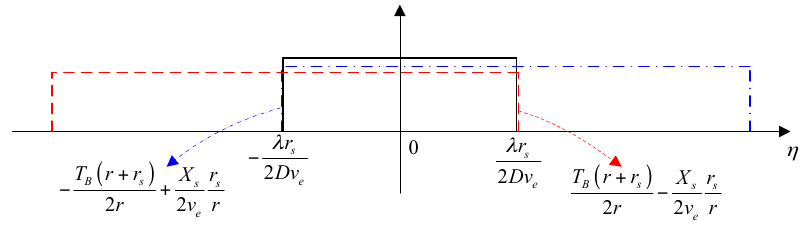
Figure 4. The value range of azimuth signal after a derotation operation, which is limited by Equation (14) (black solid rectangular window), Equation (17) (red dashed rectangular window), and Equation (18) (blue dash-dot rectangular window).